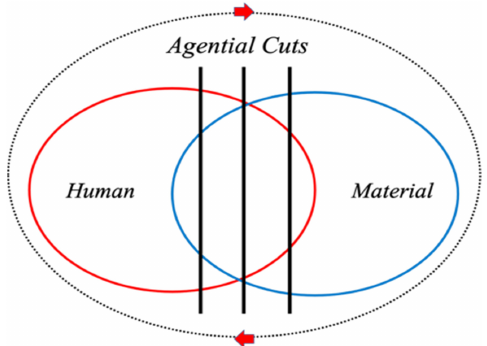
Figure 2. Agential Realism and Agential Cut.